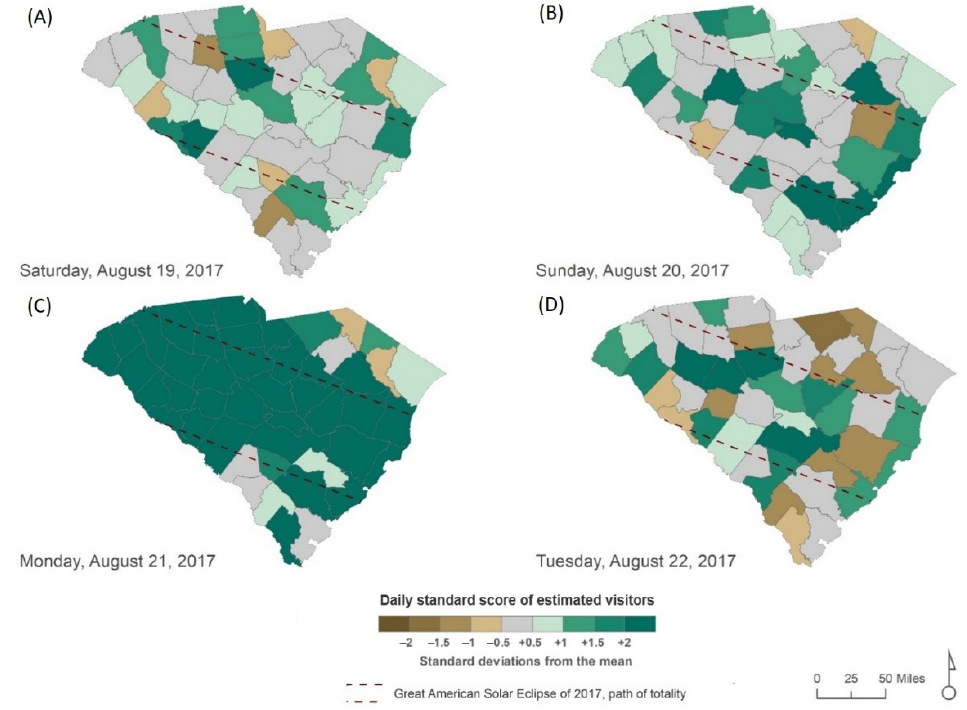
Figure 4. Daily standard score of estimated visitors from 19 August to 22 August 2017 in South Carolina. ( A ) Saturday, 19 August 2017, ( B ) Saturday, 20 August 2017, ( C ) Saturday, 21 August 2017 (solar eclipse day), ( D ) Saturday, 22 August 2017.